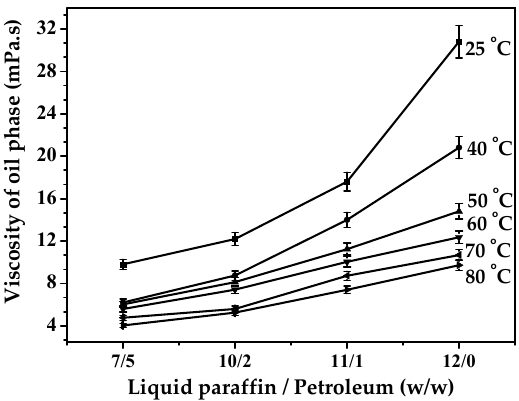
Figure 8. Viscosities of oil phase with different weight ratios of liquid paraffin to petroleum ether.